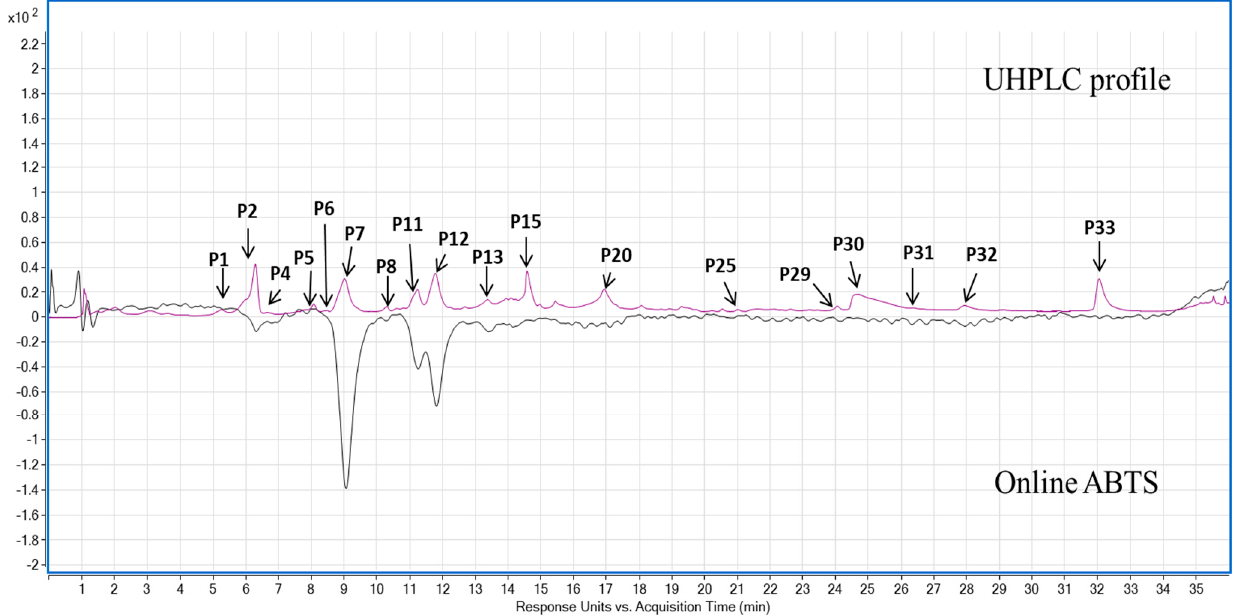
Figure 5. Ultra-high performance liquid chromatography (UHPLC) coupled with an online 2,2 ′ -azino-bis (3-ethylbenzothiazoline-6-sulfonic acid) (ABTS •+ ) antioxidant activity mapping of polyphenols from purple barley methanol extract. Purple line: phenolic profile at 280 nm; Black line: online ABTS antioxidant activity profile at 414 nm.